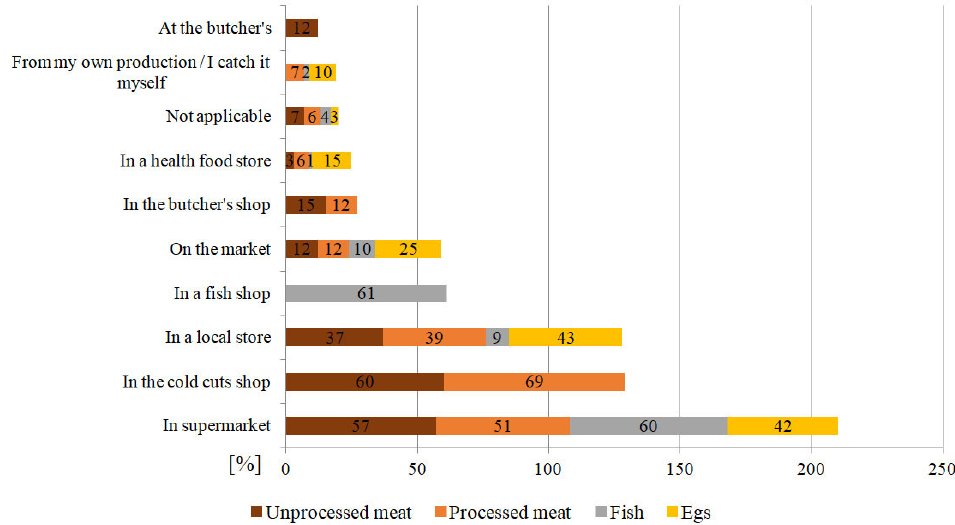
Figure 1. Supply sources of unprocessed and processed meat, fish, and eggs [%] regarding to respondents.